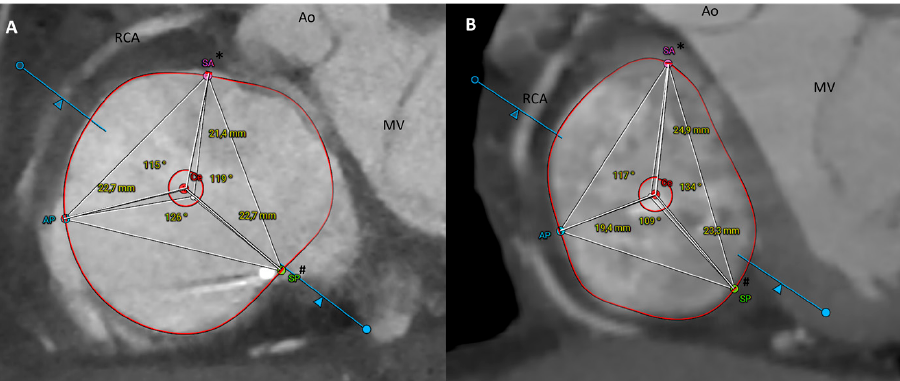
Figure 1. CT scan analysis using 3mensio Structural Heart 10.3 (Pie Medical Imaging, Maastricht, The Netherlands) in a patient with severe tricuspid regurgitation ( A ) and control ( B ). The different geometrical shape of the tricuspid annulus is appreciable: quite circular in ( A ) and more oval in ( B ). AP: antero-posterior commissure; Ce: centroid; SA: septal-anterior commissure SP: septal-posterior commissure. *SA corresponds to AS antero-septal commissure in the main text and tables; # SP corresponds to PS postero-septal commissure in the main text and tables. Table 1. Overview of the CT scan parameters analyzed offline.